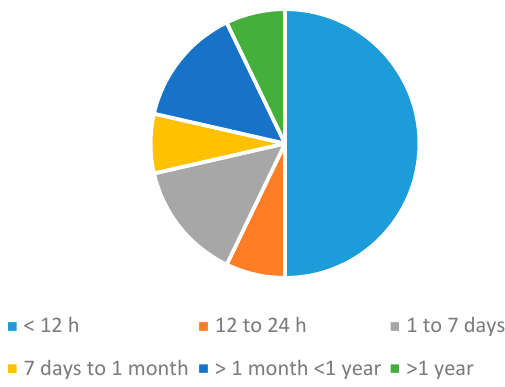
Figure 23. Distribution of battery lives reported in the respiratory monitoring studies.